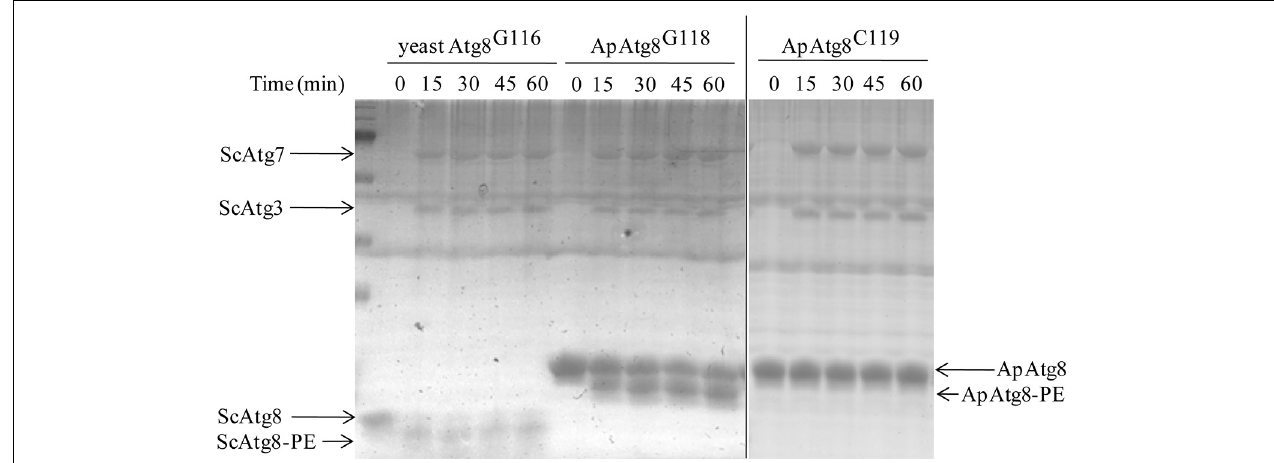
C-terminal glycine residue was exposed), and Atg12. Yeast Atg8 G116 and the nascent from of ApAtg8 (ApAtg8 C119 ) were used as positive and negative controls, respectively.